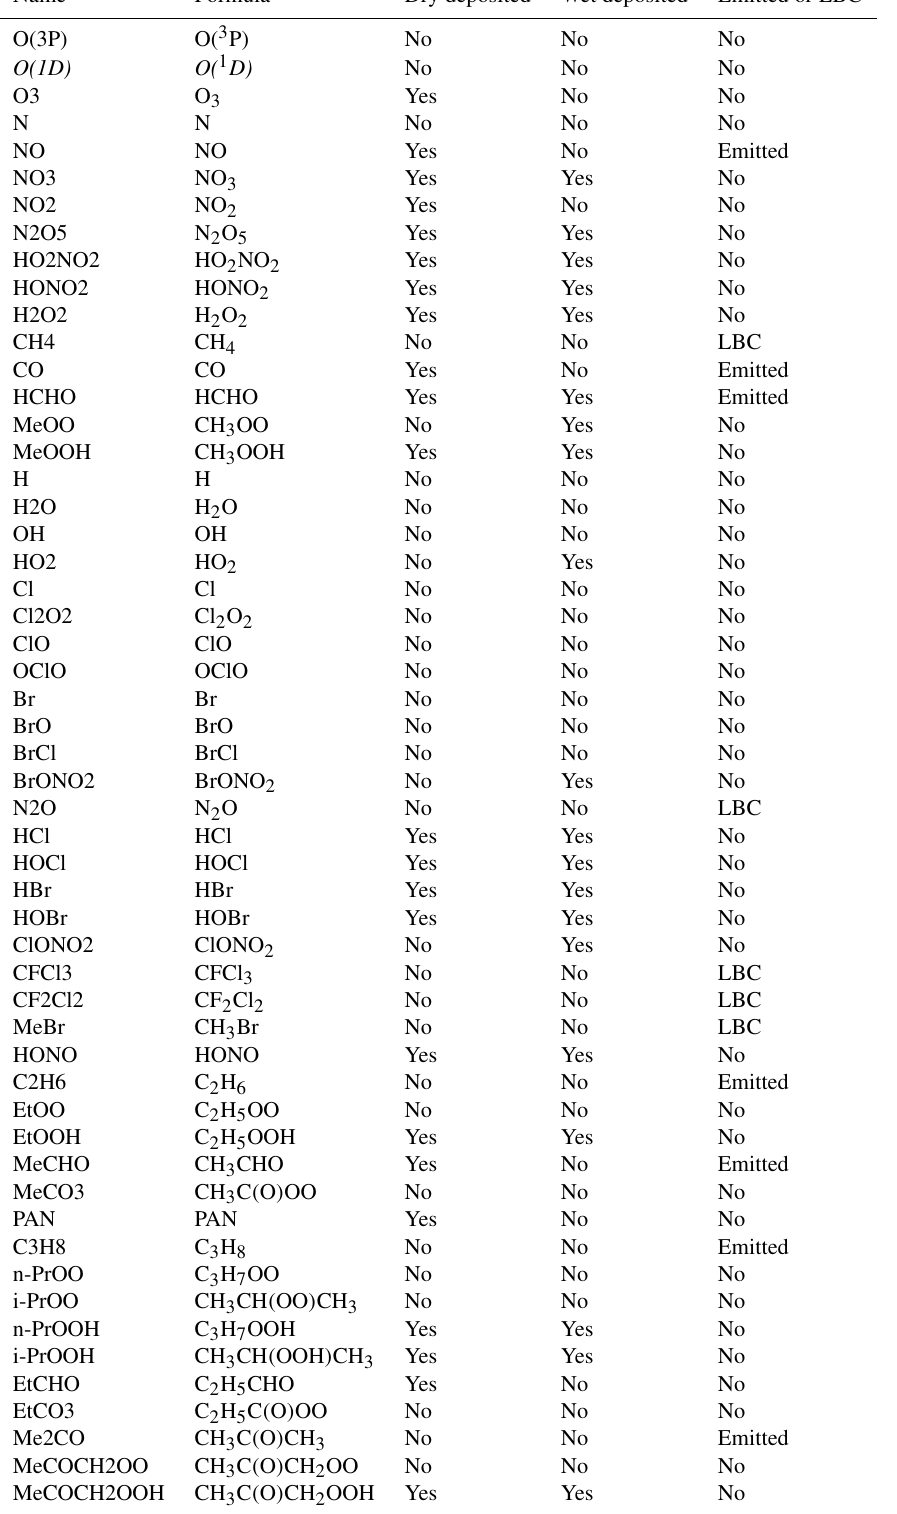
Table 1. List of chemical species in UKCA StratTrop. Species in italics are not advected tracers but are calculated using a steady-state approximation. Species in bold are set as constant mixing ratios throughout the